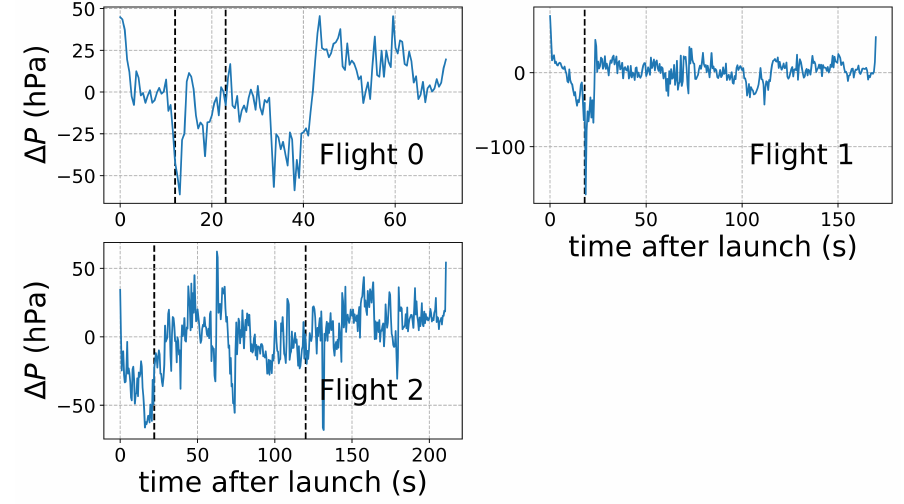
Figure 8. Pressure residuals after removing the linear, hydrostatic trends shown in Figure 7. The dashed, black vertical lines represent the approximate dust devil encounter times estimated from the video data (Section